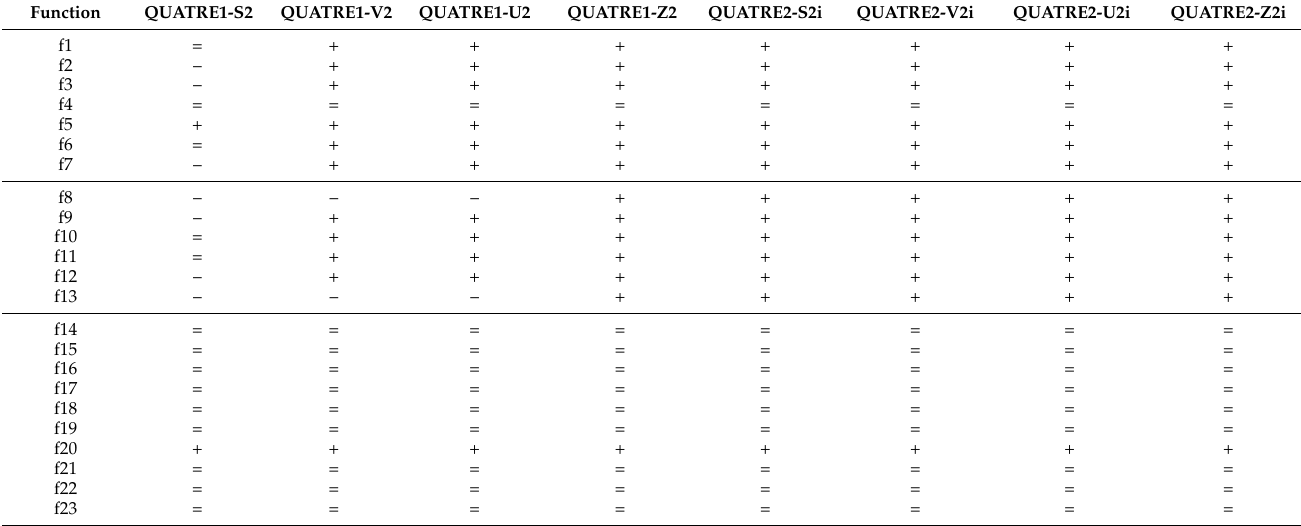
Table 15. The t -test results of the compared algorithms (QUATRE1-S2, QUATRE1-V2, QUATRE1-U2, QUATRE1-Z2, QUATRE2-S2i, QUATRE2-V2i, QUATRE2-U2i, and QUATRE2-Z2i) on ABGWO-V3a. Function QUATRE1-S2